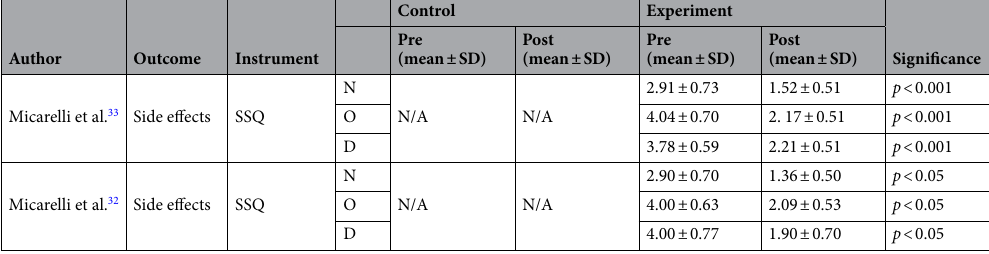
Table 4. Study results for virtual reality side effects. D disorientation, N nausea, O oculomotor stress, SD standard deviation, SSQ simulator sickness